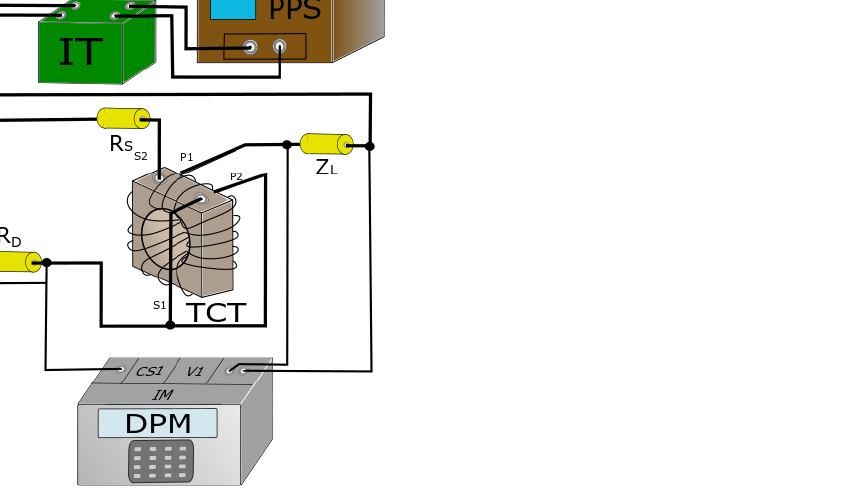
Figure 1. Measuring setup used for evaluation of values of current error and phase displacement of the CTs.